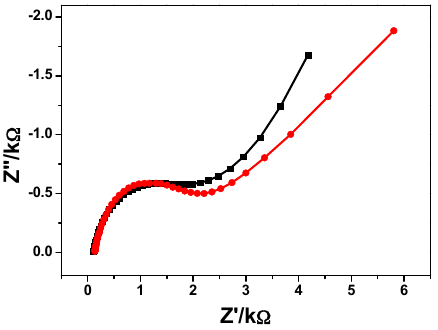
Figure 9. Nyquist plots for GCE/PDMA-MWCNT (black) and GCE/PDMA-MWCNT/anti-Fms (red). Table 1. Electrochemical impedance spectroscopy (EIS) parameters for GCE/PDMA-MWCNT and GCE/PDMA-MWCNT/anti-Fms.